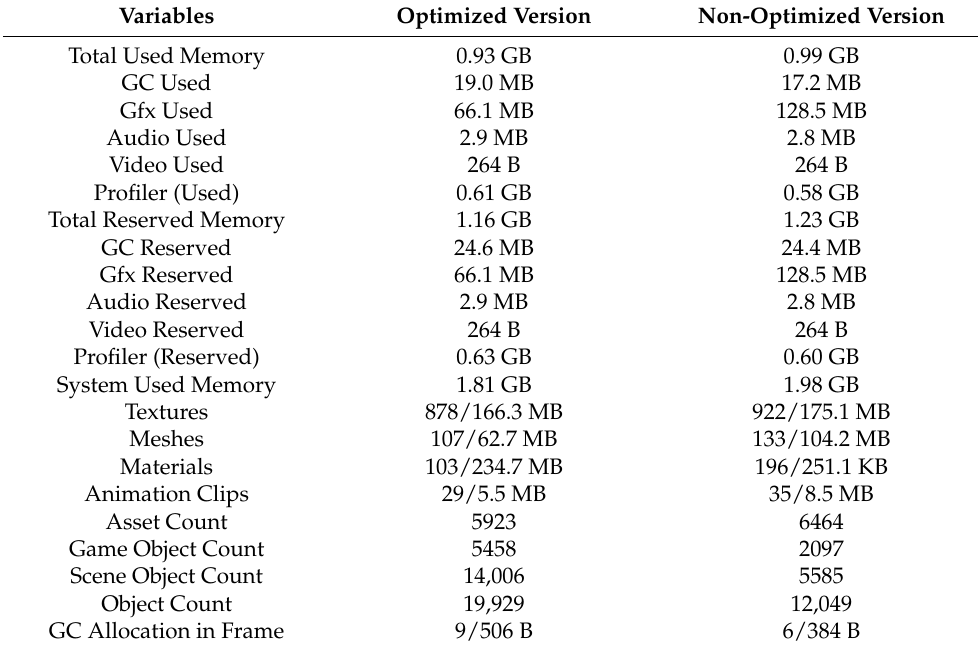
Table 6. Memory data for the frame with the lowest FPS in CPU usage diagram.